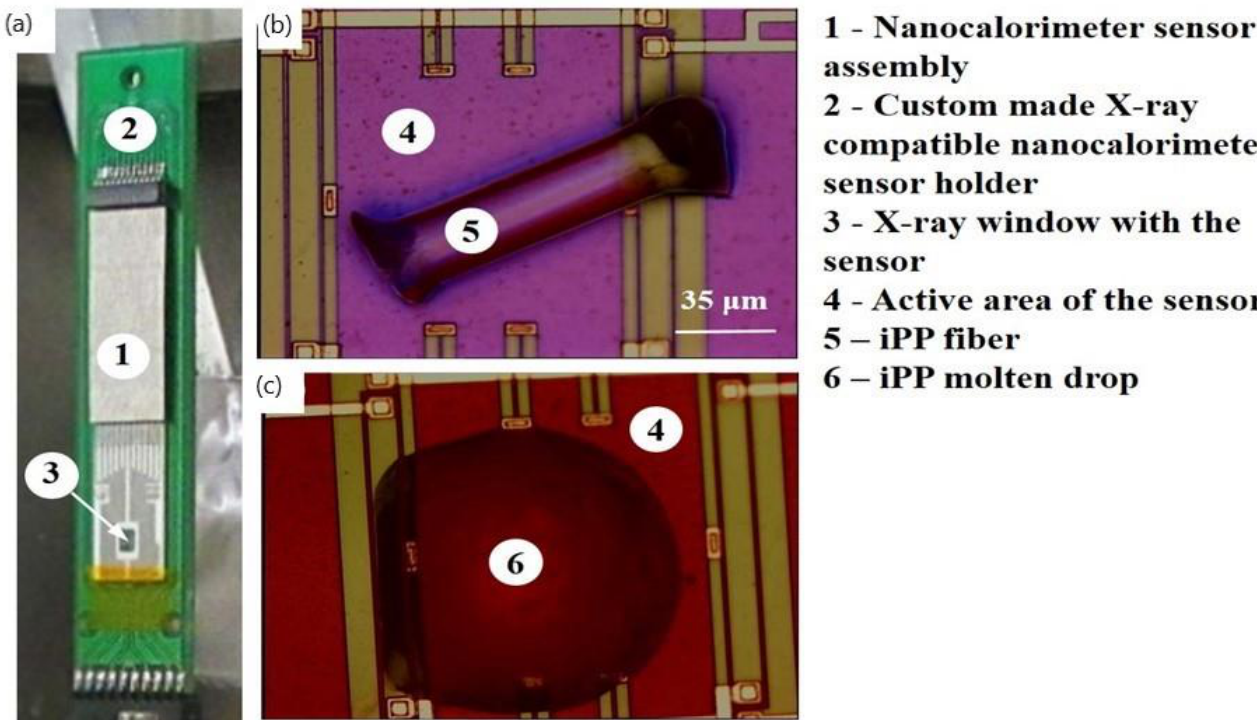
Figure 1. Nanocalorimeter sensor assembly used for nanofocus 2D Wide-Angle X-ray Scattering (WAXS). ( a ) Sensor; ( b ) a fragment of isotactic polypropylene (iPP) fibre deposited on the active area of the sensor; ( c ) a drop of molten iPP formed after the first heating cycle.